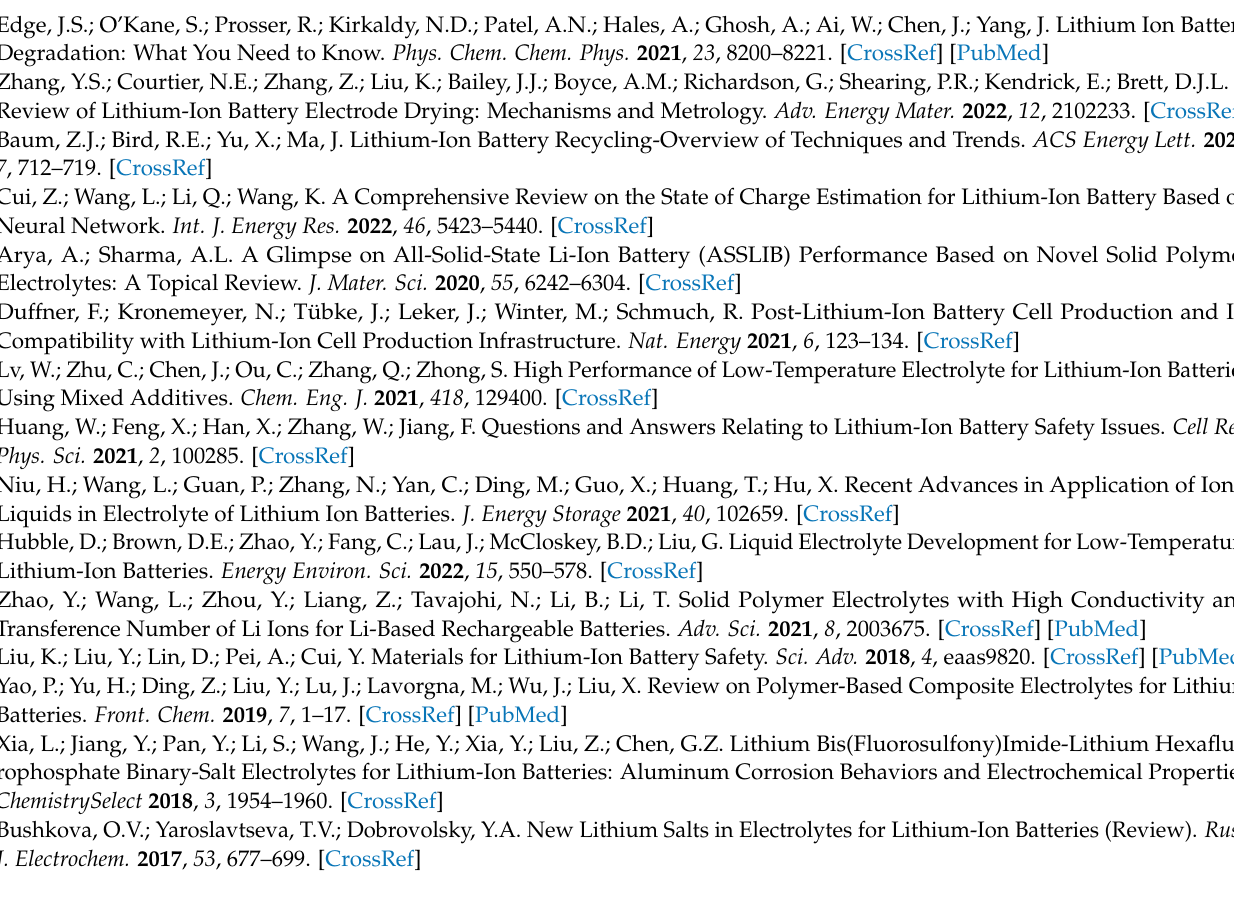
preparation. Figure S3. Impedance spectra of (a) SPE-50, (b) PE-10, (C) PE-30 and (d) PE-50. Figure S4. Z-view fitting result and current model. Table S1 Currents and resistances of the electrolytes for t Li+ calculation. Figure S5. CV plots of polymer electrolytes at room temperature with a scan rate of 1 mV s − 1